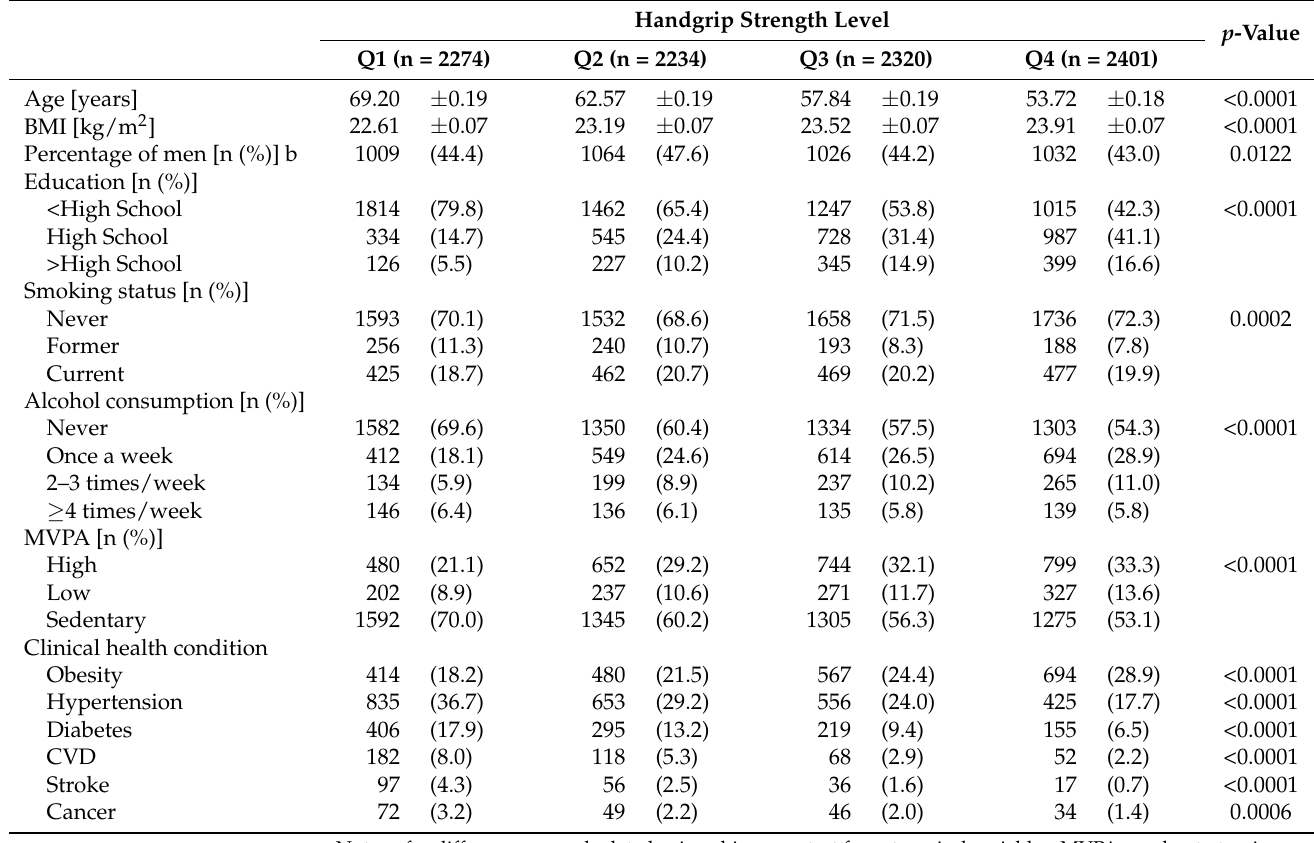
Table 2. Participant characteristics by handgrip strength level.